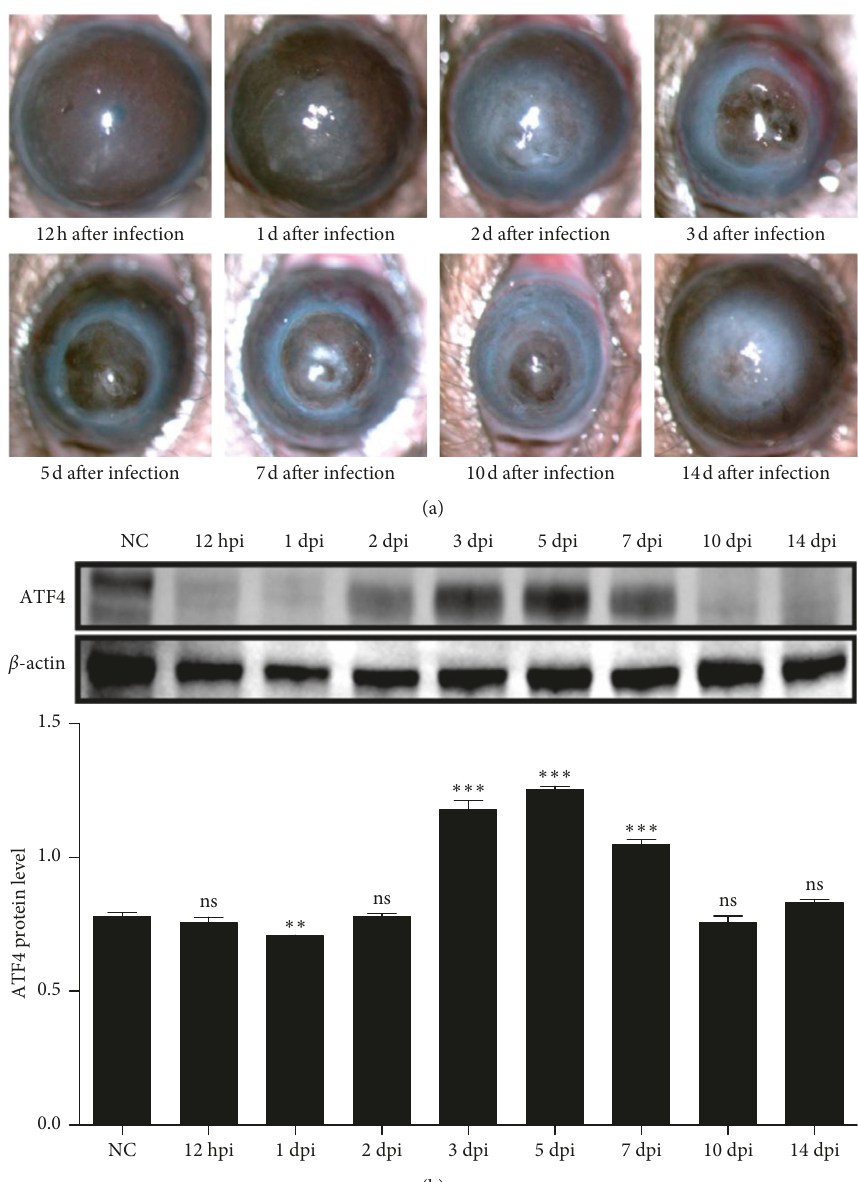
Figure 1: ATF4 was increased in mice corneas of A. fumigatus keratitis developed by intrastromal injection. (a) Significant corneal opacity of C57BL/6 mouse models was developed by intrastromal injection formed 1 day after infection and persisted up to 14 days. Corneal inflammation gradually improved with increased neovascularization. (b) After A. fumigatus infection, ATF4 protein expression was confirmed by western blot to be degraded in mouse corneas at 1 day after infection, elevated at 3 days, and then persisted up to 7 days. As the inflammation subsided, ATF4 expression returned to normal after 10 days. Mean values and standard deviations of two independent experiments are shown; ∗∗ P < 0 . 01, ∗∗∗ P < 0 .